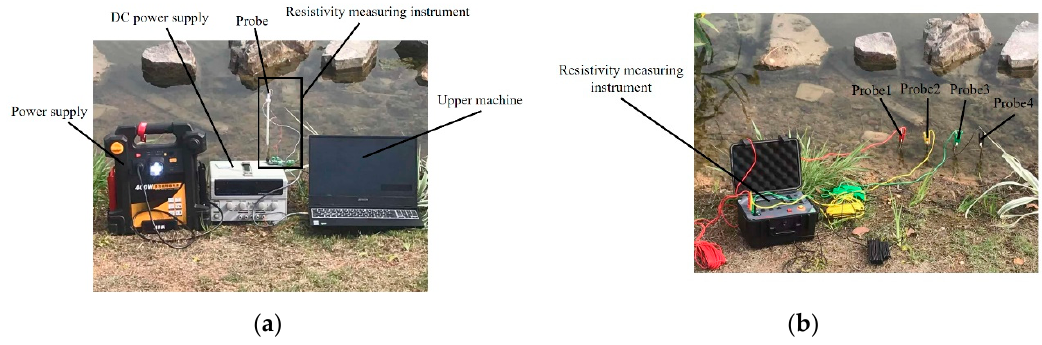
Figure 19. Site 1 of Qizhen Lake developed instrument ( a ) standard instrument; ( b ) field test diagram (unit: Ω · m). The resistivity and average values measured by developed and standard measuring instruments at Site 1 of Qizhen Lake are shown in Table 4. Table 4. The resistivity and average values measured by developed and standard measuring instruments at Site 1 of Qizhen Lake.